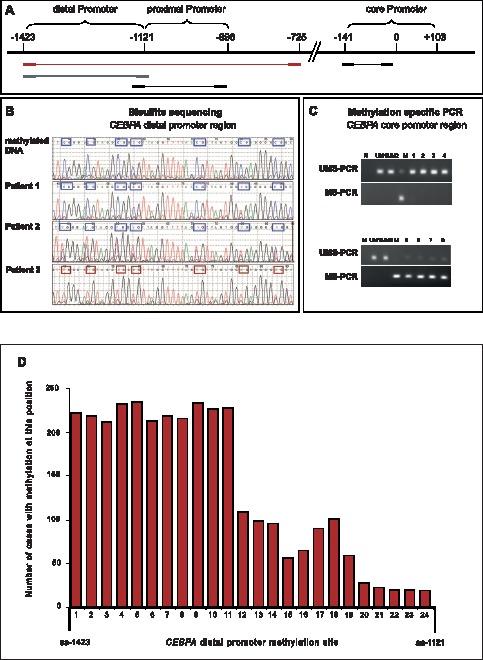
DNA methylation analysis of the CEBPA core promoter and upstream promoter regions.
A) Scheme of the CEBPA promoter region. The areas of DNA methylation analysis are shown below. Red: CEBPA-promoter outer primers; grey: CEBPA distal PM primers, black: CEBPA proximal PM primers; blue: CEBPA-U and CEBPA-M primers; BS: Bisulfite Sequencing; MSP: Methylation specific PCR. B) Bisulfite sequencing results for the distal CEBPA promoter region for 3 individual cases compared to positive control. Boxes indicate individual CpG sites analyzed. CG indicates a methylated CpG site; TG indicates an unmethylated CpG site. The distal CEBPA promoter region of patient 1 is fully methylated (level of methylation: 75–100%), patient 2 is partly methylated (level of methylation: 20–50%) and patient 3 is unmethylated (level of methylation: <15%). C) MSP for CEBPA core promoter with CEBPA-U and CEBPA-M primers. Upper: N: Non-template control; UM1/UM2: positive controls with unmethylated DNA; M: positive control with methylated DNA. 1–4 samples of patients showing positive amplification in UMS-PCR but not in MS-PCR. Lower: 5–8: samples of patients showing positive amplification in MS-PCR but not in UMS-PCR; D) Frequency and distribution of methylated CpG islands within the distal CEBPA promoter region. Bar chart showing the frequency and distribution of methylated CpG islands within the distal CEBPA promoter region for 238 cases with CEBPA distal promoter methylation.